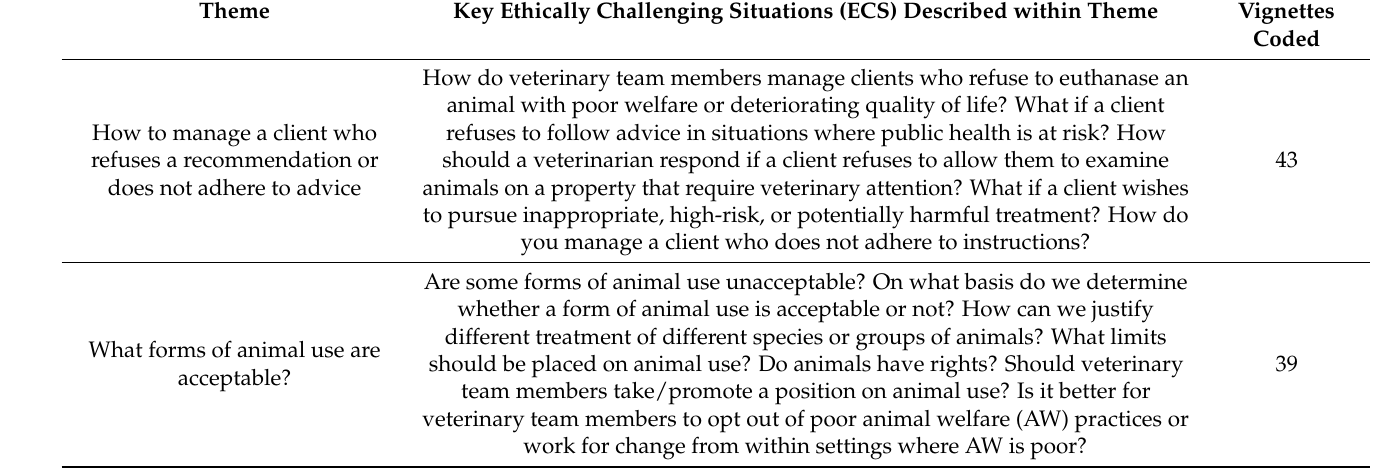
Figure 3. Bar chart depicting the primary category of animal in ethical vignettes ( n = 567). Themes generated from the types of ECS described in the vignettes are described in Table 3. In total, 29 themes were generated. Table 3. Themes generated from a review of ethical vignettes published in the veterinary literature from 1990 to 2020, with a summary of key ethically challenging situations described within each theme.